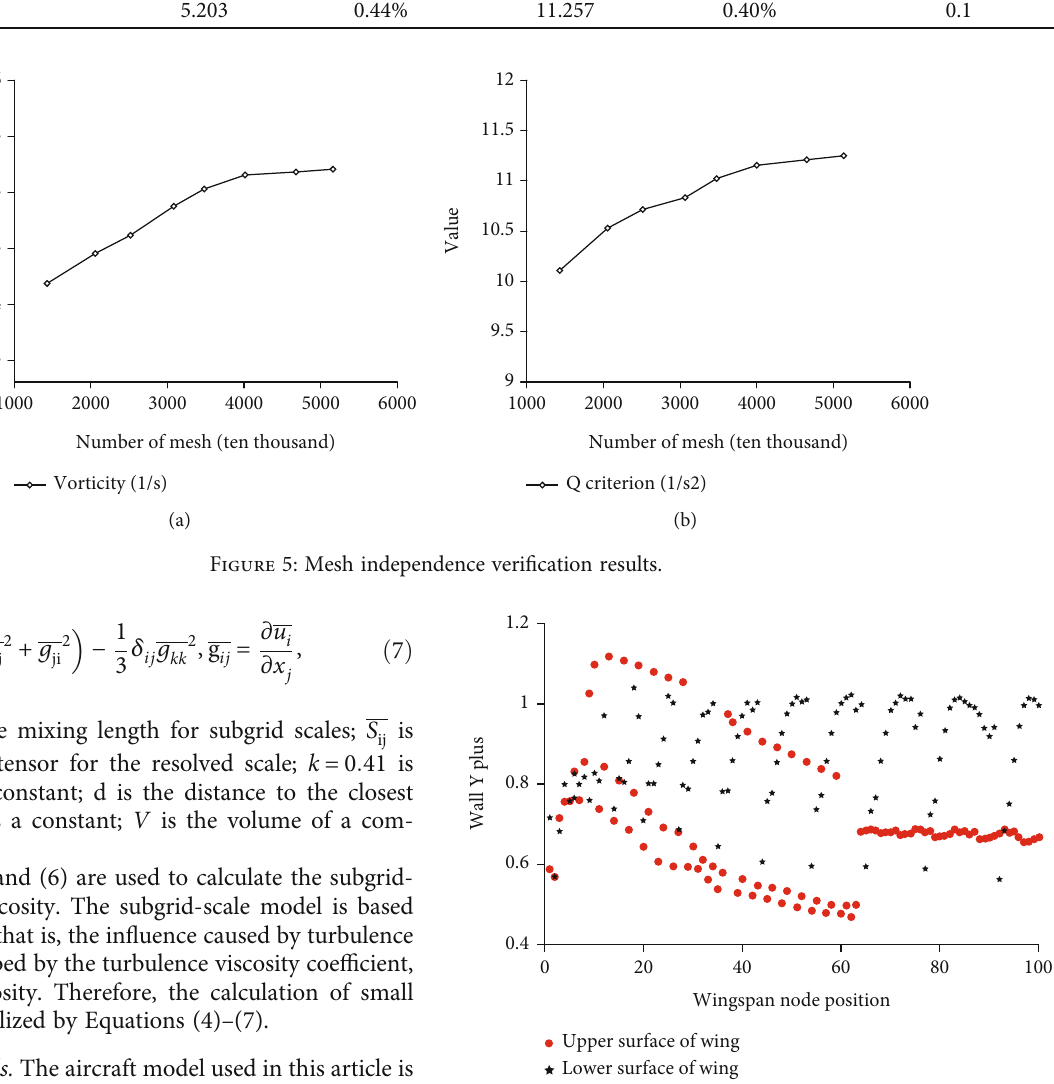
Figure 6: Y plus value of the wing